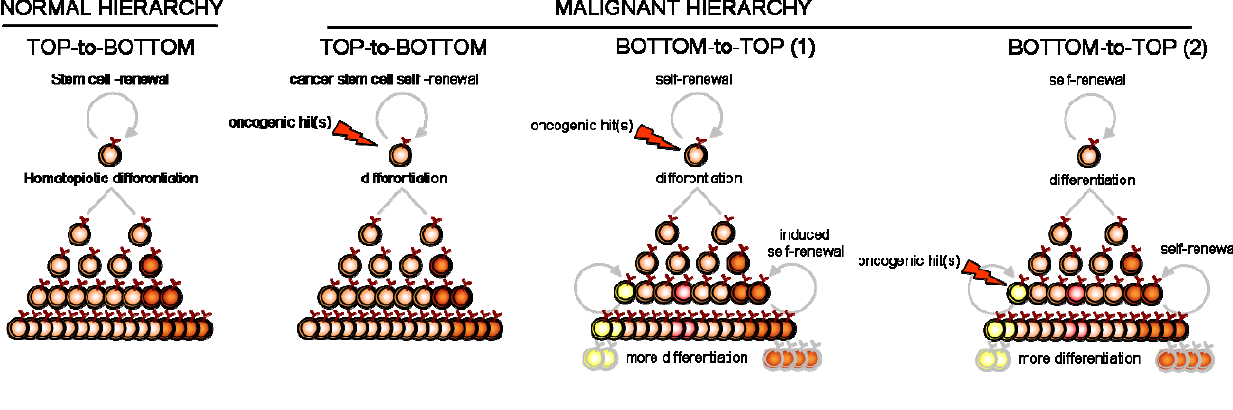
Figure 2. Models of clonal progenies in normal and malignant contexts. Note that the difference between bottom-to-top models 1 and 2 is the target of the oncogenic